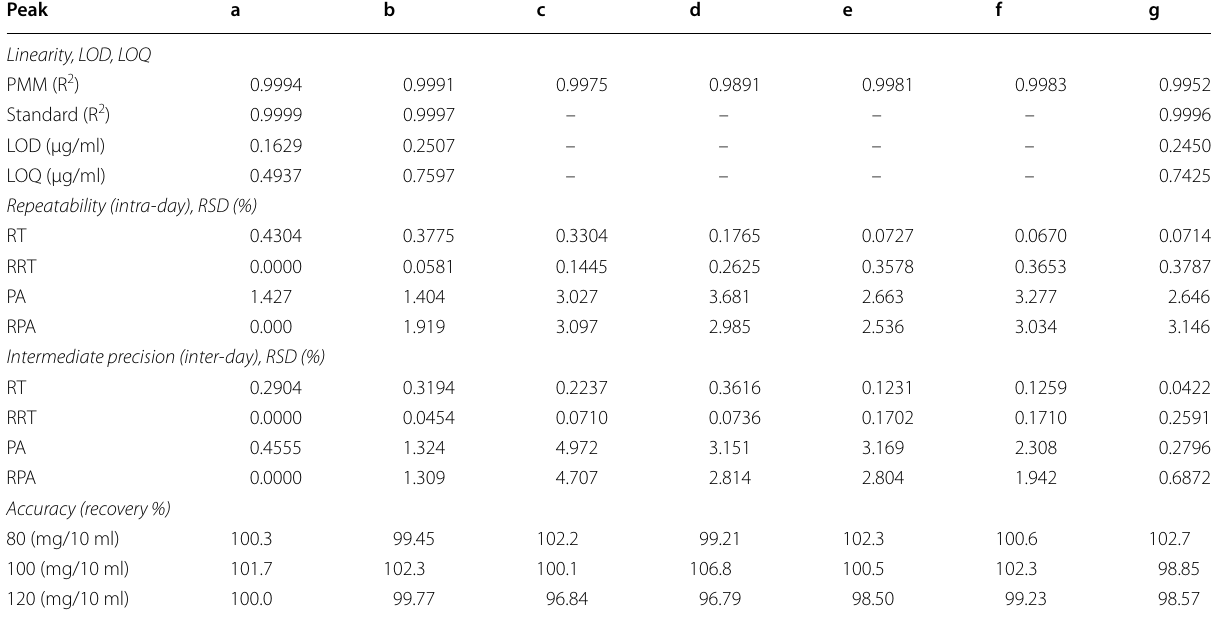
Table 2 Linearity, precision, and accuracy test for method validation